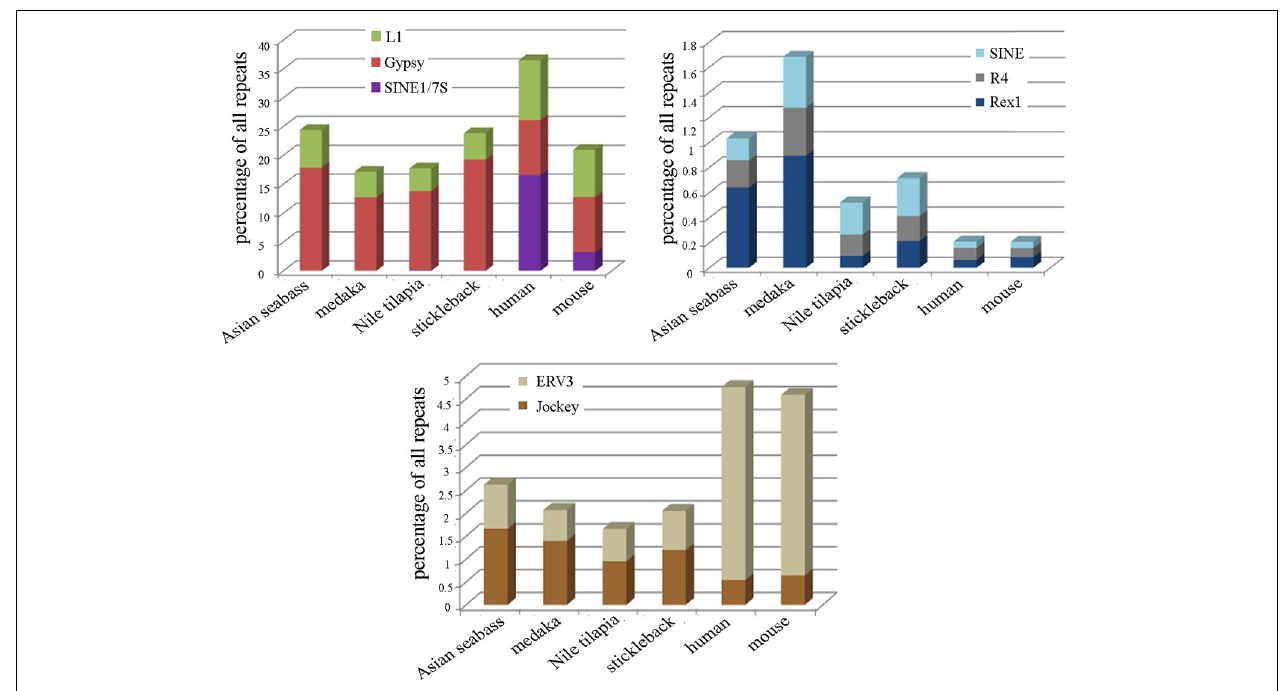
FIGURE 7 | The relative proportion of eight repeats is different among the transcriptomes of teleosts and mammals. The following repeats were analyzed: Jockey, ERV3, Rex1, R4, SINE, SINE/7SL, Gypsy, and L1 in the transcriptomes of Asian seabass,